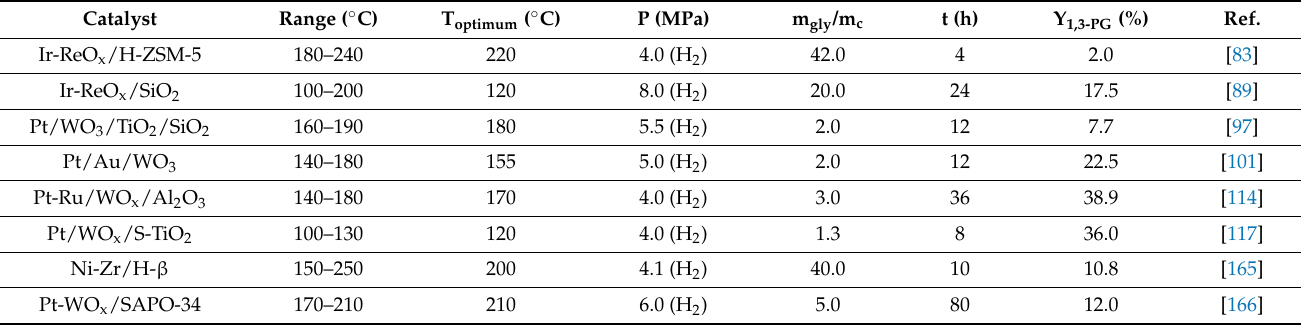
Table 9. The thermal effect studied in batch reactors using different catalysts.